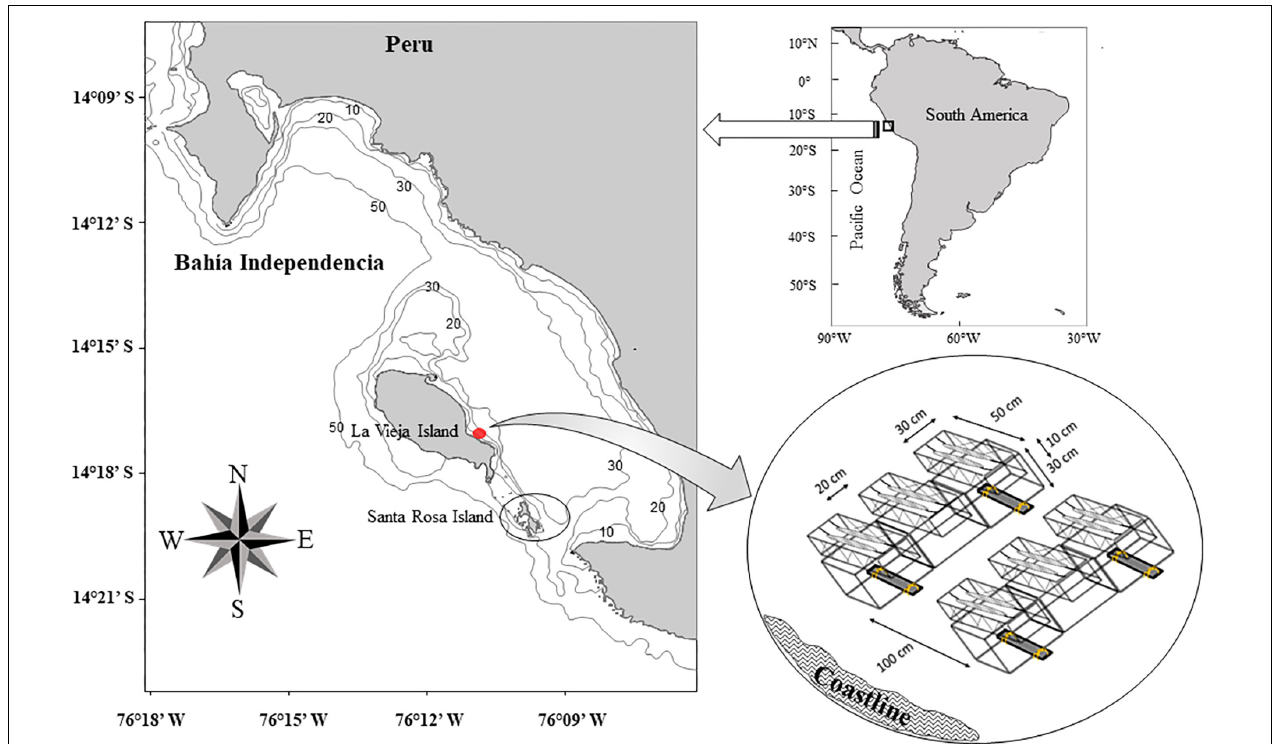
FIGURE 1 | Map of the study area (Isla Santa Rosa-Bahía Independencia), with the sampling location for adult Aulacomya atra (black circle) and the location of the system to monitor larval settlement (red point) at La Vieja Island.